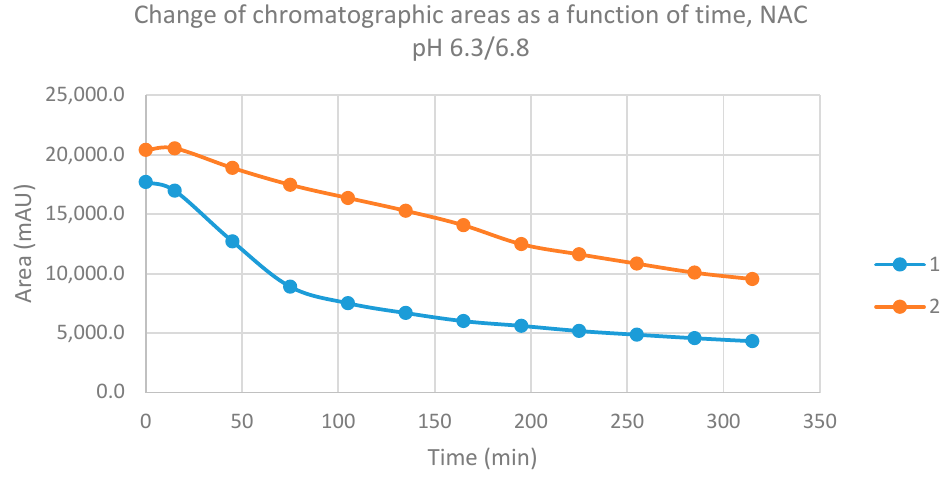
Figure 8. Change in the chromatographic peak area of chalcones 1 and 2 in the chalcone–NAC incubations at pH 6.3/6.8.